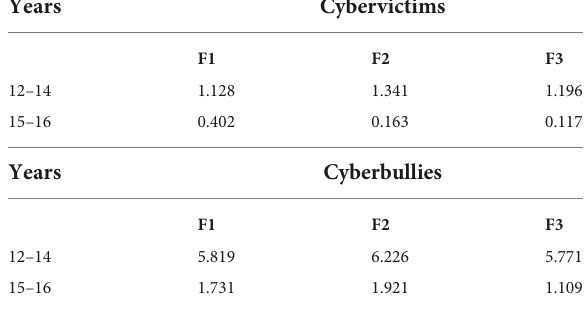
TABLE 2 Percentage of responses given in the social skills scale for young immigrants (SSSYI) and cyberbullying scale for students with cultural and religious diversity (CSCRD).